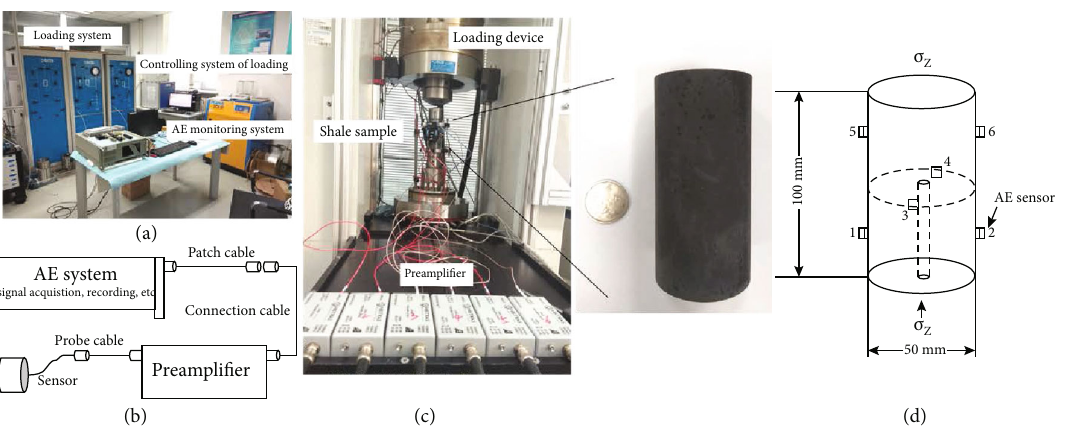
Figure 1: The GCTS RTR-2000 rock mechanic system and the experimental setup. (a) The experimental loading system, controlling system, and acoustic emission (AE) monitoring system. (b) The principle sketch of the AE monitoring system. (c) The loading device and preampli fi ers. (d) The sample parameters and the sensor